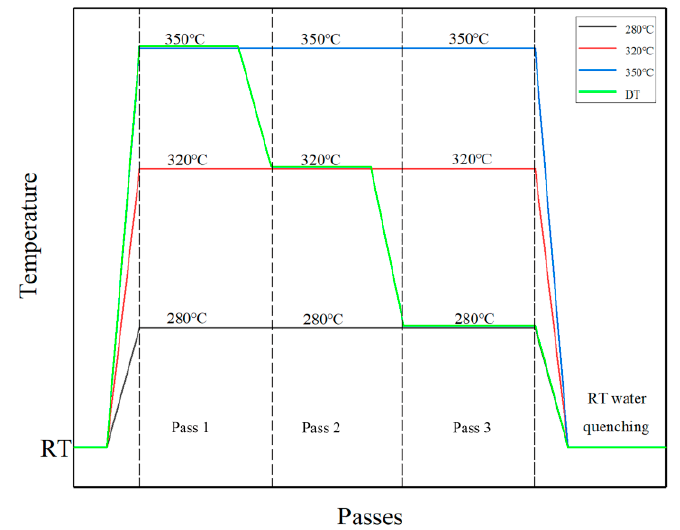
Figure 2. The schematic diagram of the experiment procedure.